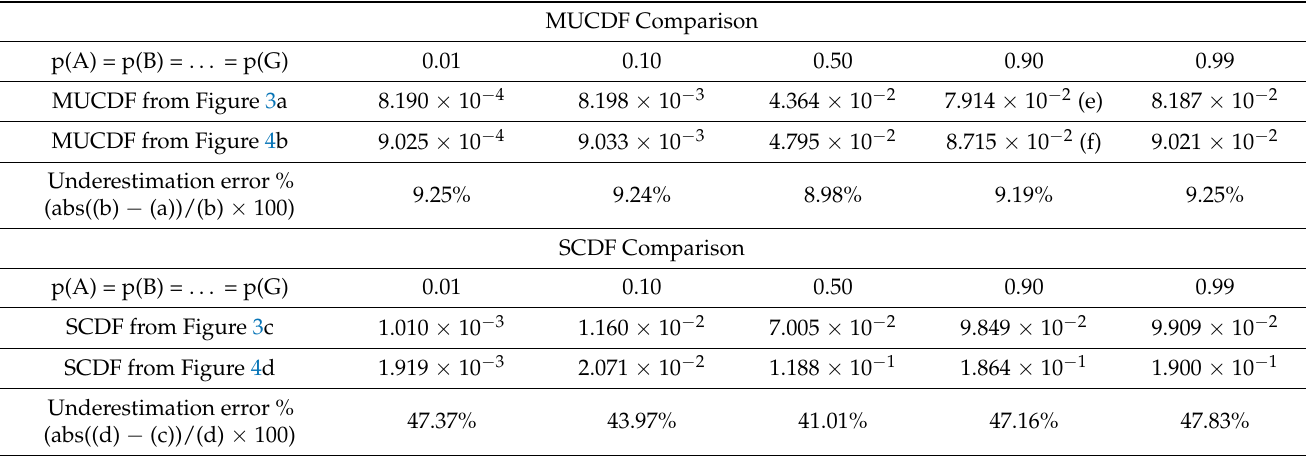
Table 2. Comparison of MUCDFs and